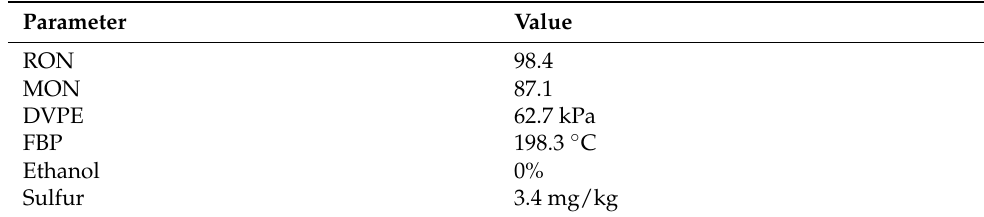
Table 2. Specification of the test